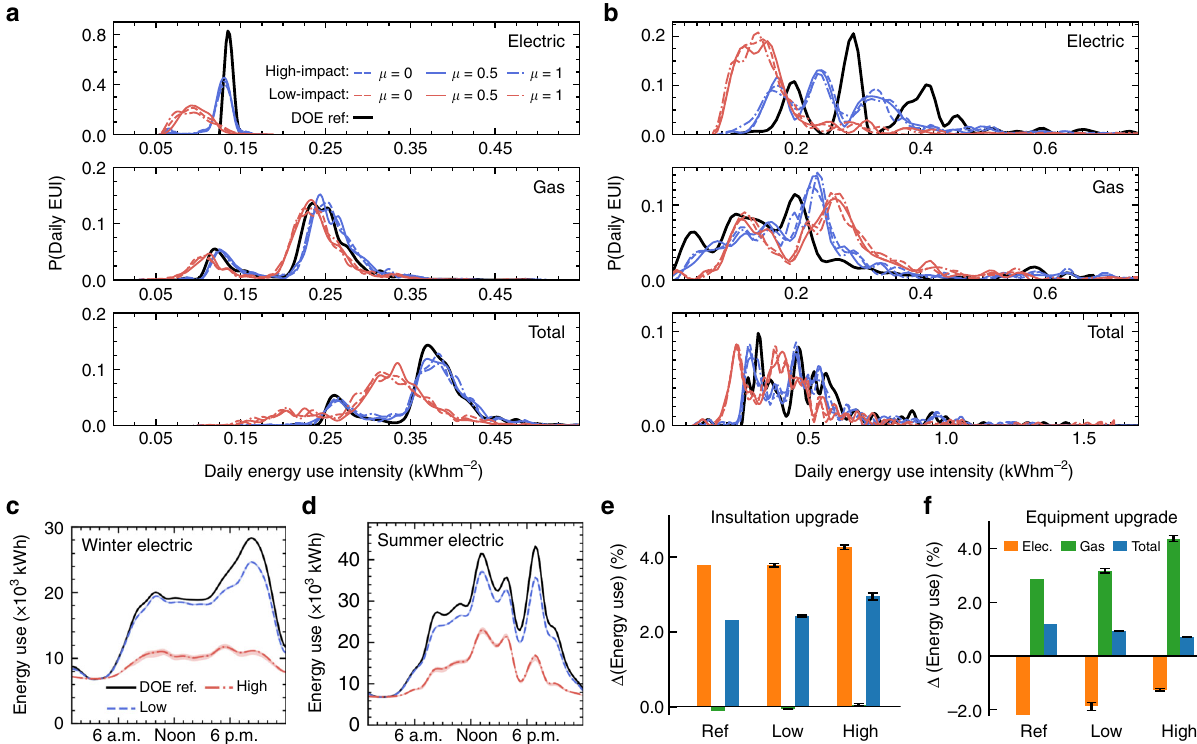
Fig. 5 Scenario energy consumption predictions. a Distribution of the daily EUI for all residential-only buildings for μ = 0, μ = 0.5, and μ = 1 occupancy. b Distribution of the daily EUI for all non-residential-only buildings. c Hourly electricity use results for winter in each scenario (shading denotes the range from the different μ values). d Hourly electricity use results for summer in each scenario. e Median change in energy use (original minus upgrade) from upgrading the insulation effectiveness in residential spaces under each scenario. Error bars illustrate the range of predictions for different μ values. f Median change in energy use from upgrading the equipment ef fi ciency in commercial spaces under each